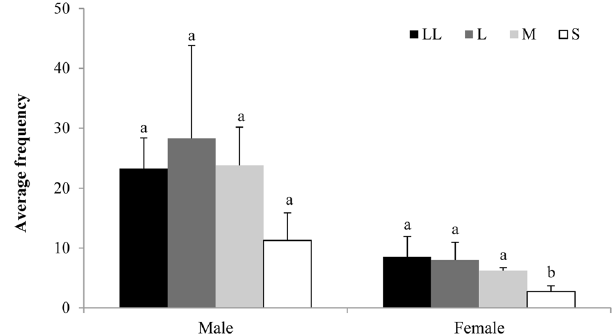
Figure 3. The number of male and female visits to four different sized female models. LL: female 1 1/2 times normal size (wing span 9.84 cm); L: normal sized female (wing span 6.56 cm); M: female reduced to the male size (wing span 6.03 cm), and S: female 1 / 2 normal size (wing span 3.28